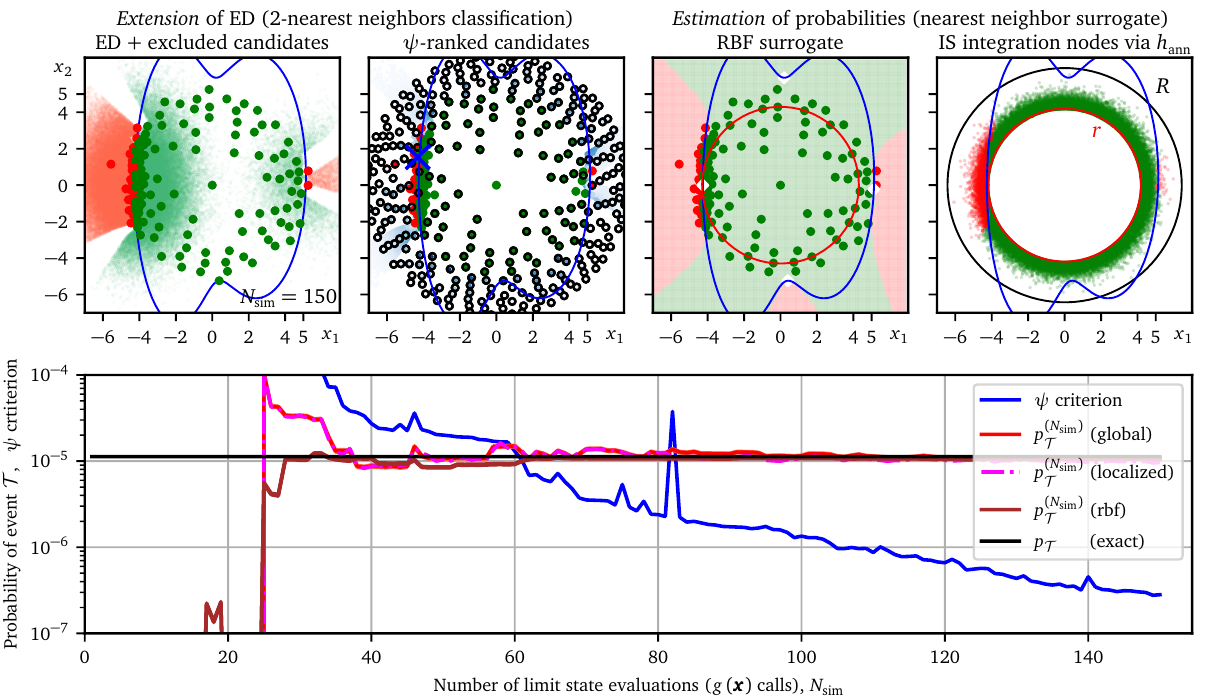
Figure 8. The ”MetaBalls” problem. The complete evolution of all panels is available in the MetaBalls video